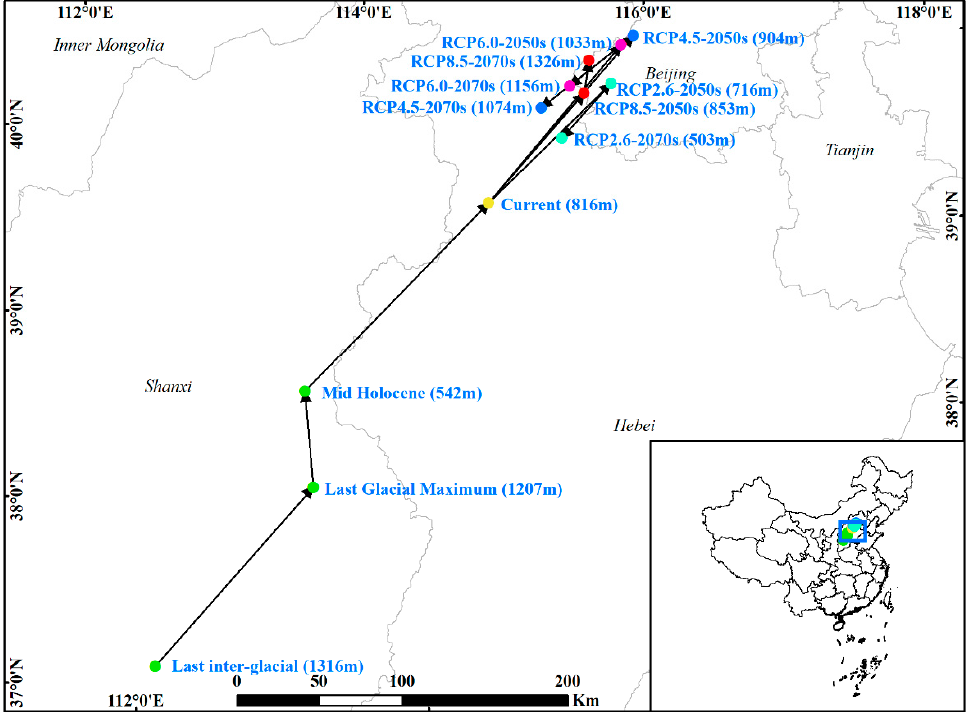
Figure 6. Shifts of centroids under different scenarios.